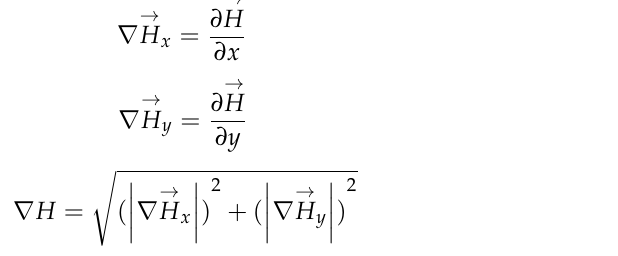
Figure 6. ∇ H simulation value change curve in the X direction. The magnitude of magnetic force can be represented by the product of magnetic field intensity and magnetic field gradient (H ·∇ H), but H ·∇ H cannot be obtained directly in COMSOL, and can only be obtained by user-defined function, as shown in Formulas (20)–(22):